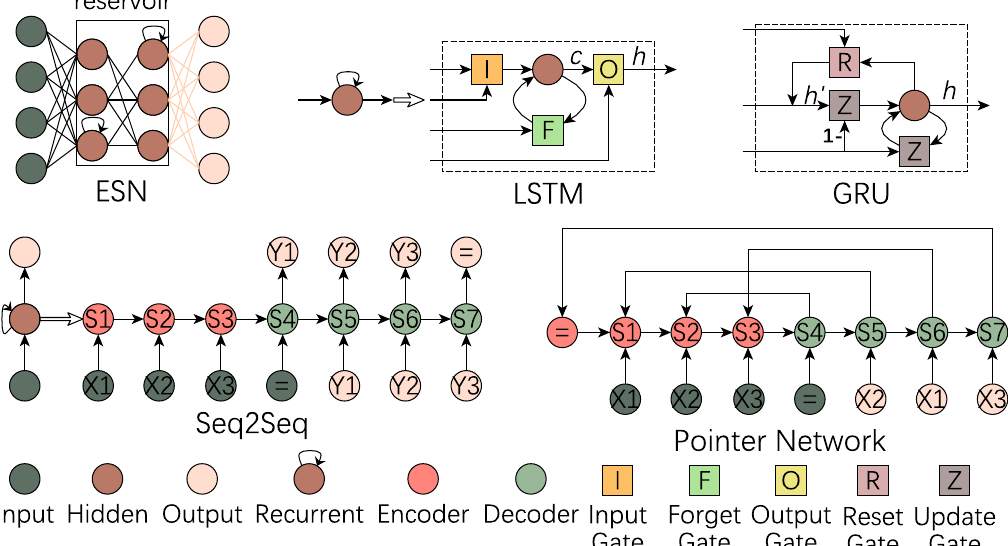
Figure 4. Recurrent Neural Network (RNN)